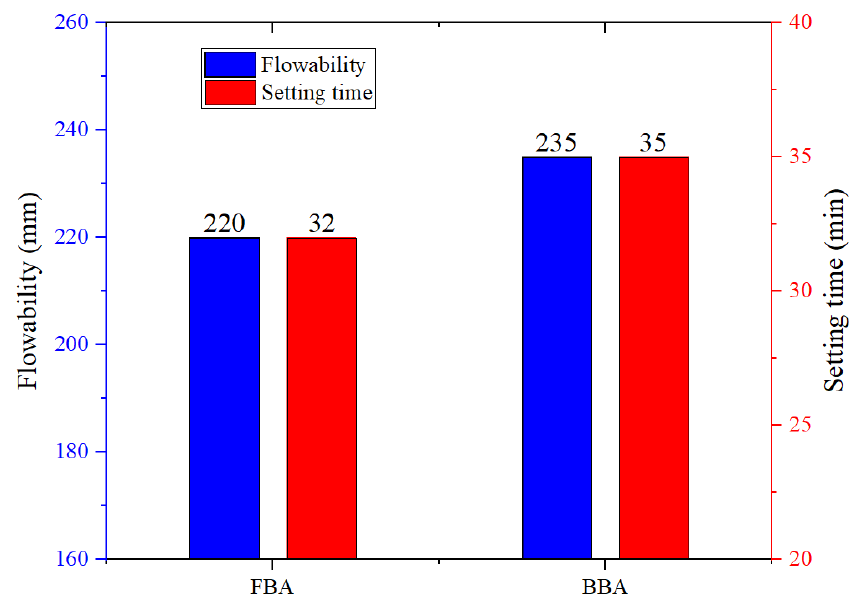
Figure 5. The effect of FBA and BBA on the flowability and setting time of MPC mortar (group 20 BA-80 MPC).